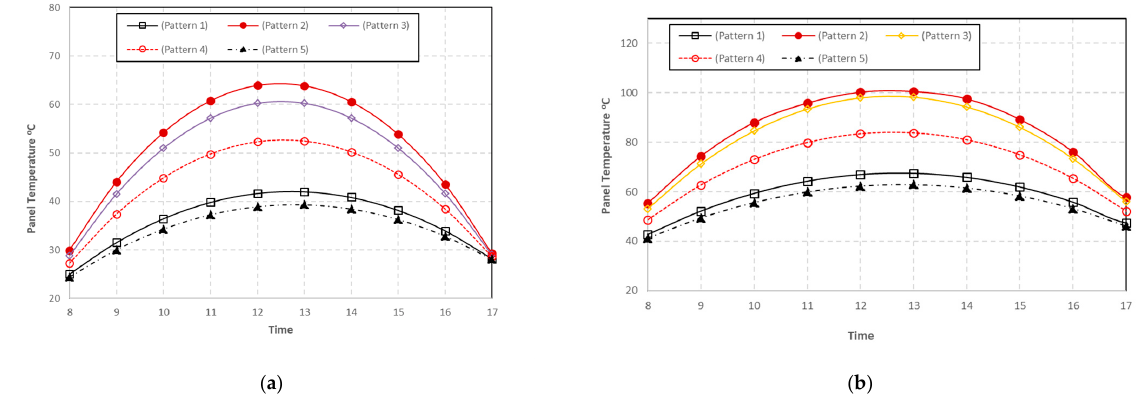
Figure 12. Hourly variations in panel temperature of PVT system for di ff erent con fi gurations. ( a ) during Winter day ( b ) during Summer day.